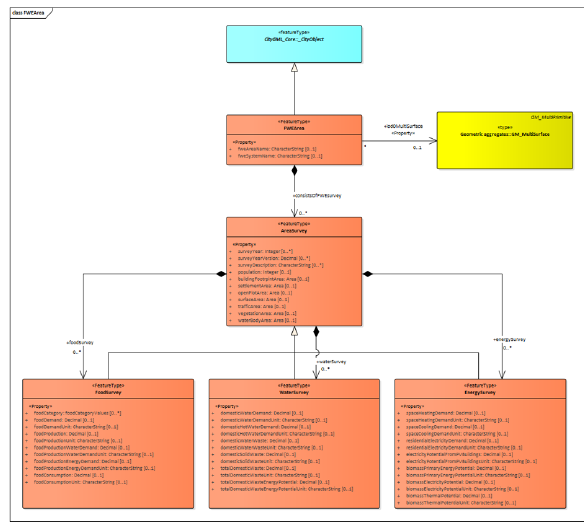
Figure 6. The UML class diagram for FWEArea